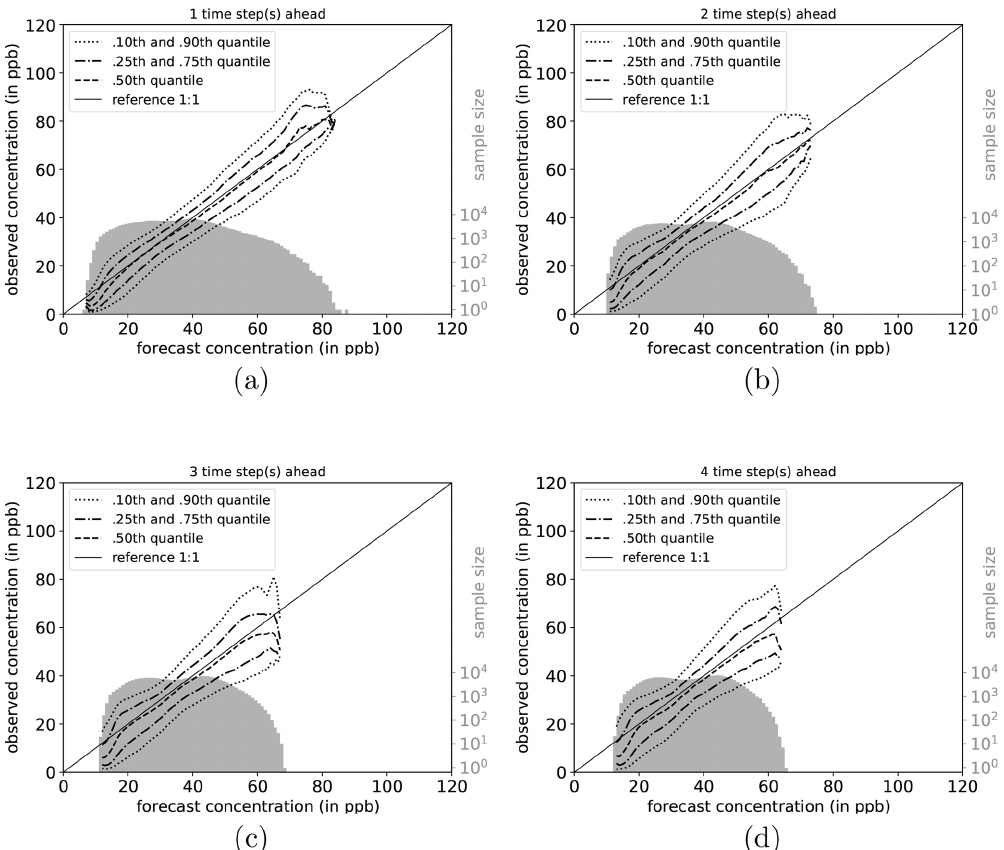
Figure 6. Conditional quantile plot for all IntelliO3-ts predictions for a lead time of 1d (a) , 2d (b) , 3d (c) , and 4d (d) . Conditional percentiles (0.10th and 0.90th, 0.25th and 0.75th and 0.50th) from the conditional distribution f (cid:0) o j | m i (cid:1) are shown as lines in different styles. The reference line indicates a hypothetical perfect forecast. The marginal distribution of the forecast f (m i ) is shown as log histogram (right axis, light grey). All calculations are done by using a bin size of 1ppb. Quantiles are smoothed by using a rolling mean of a window size of 3. (After Murphy et al.,